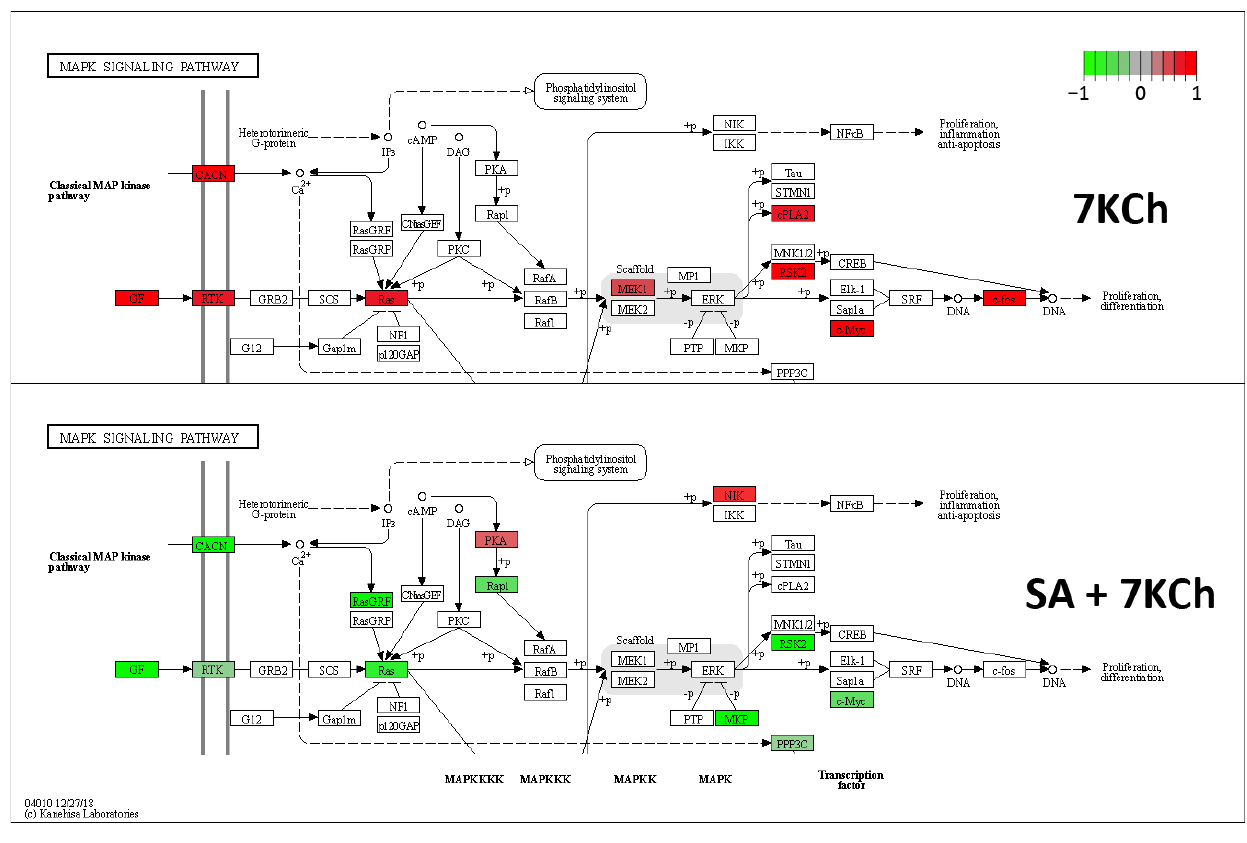
Figure 7. Classical MAPK signaling pathway altered by 15 μM 7KCh treatment in mRPE cells and reversion effect exerted by 10 μM SA over this modulation. In red, proteins expressed at higher levels than control. In green, proteins expressed at lower levels than control. Reprinted and modified with permission from Kyoto Encyclopedia of Genes and Genomes (KEGG). Copyright 2013, KEGG, Kyoto, Japan.